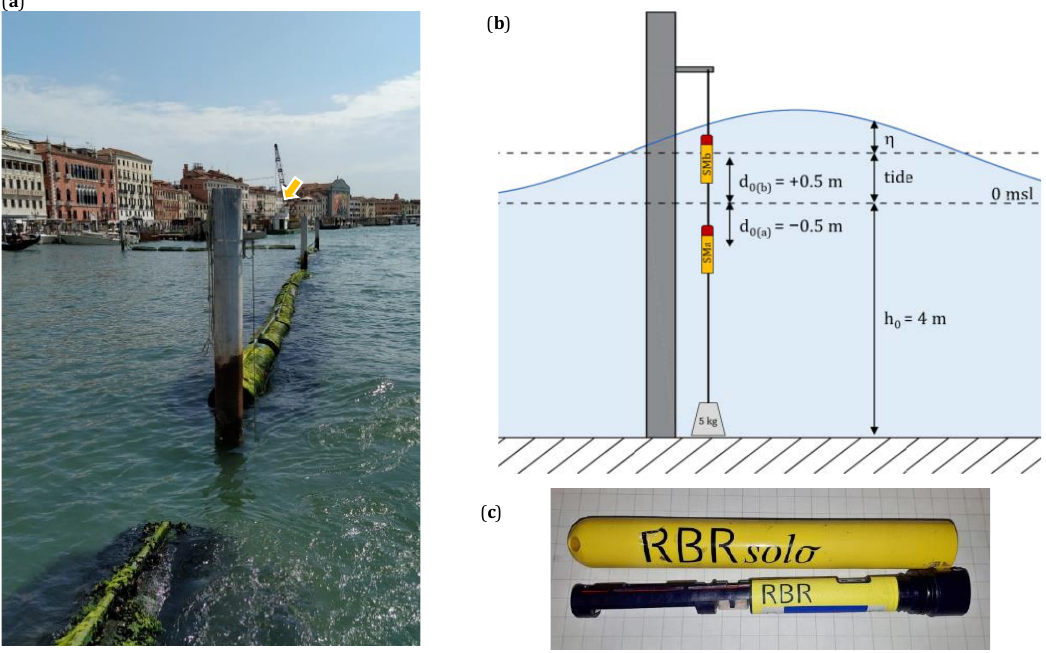
Figure 2. ( a ) Wave pressure gauges installed in a retaining pile of a small floating breakwater placed in front of San Marco square (Venice, IT). The small arrow indicates the position of the small shelf used to hang up the steel cable where the gauges are attached; ( b ) scheme of the installation (not to scale) and principal characteristics; ( c ) pressure gauges RBR Solo D wave.